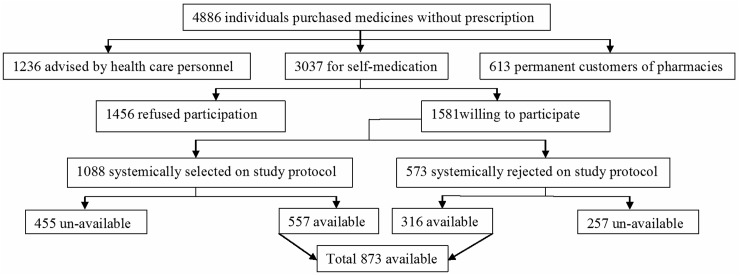
An outline of study.